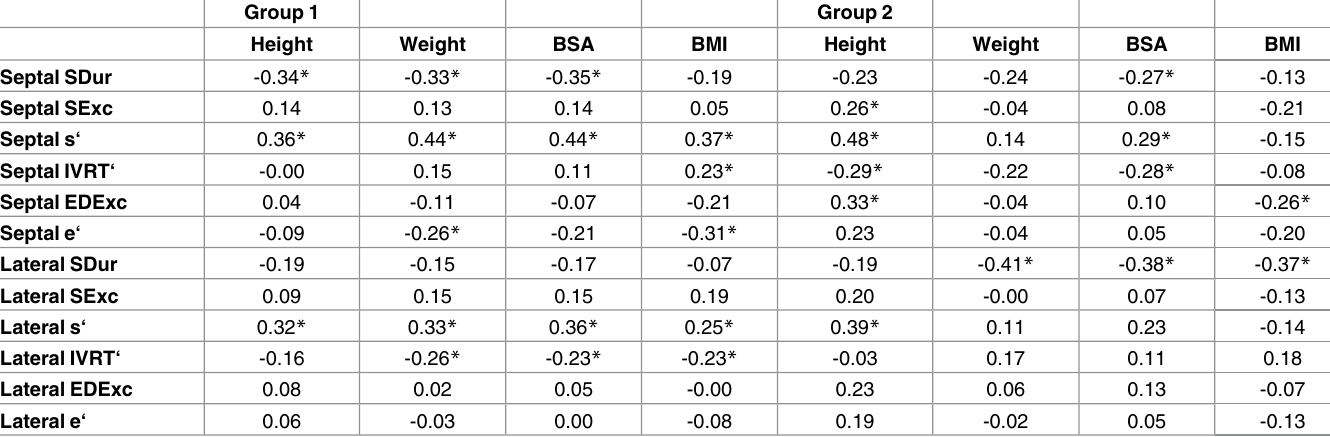
Table 4. Univariate correlations of tissue Doppler variables with height, weight, body surfacearea and body mass index.